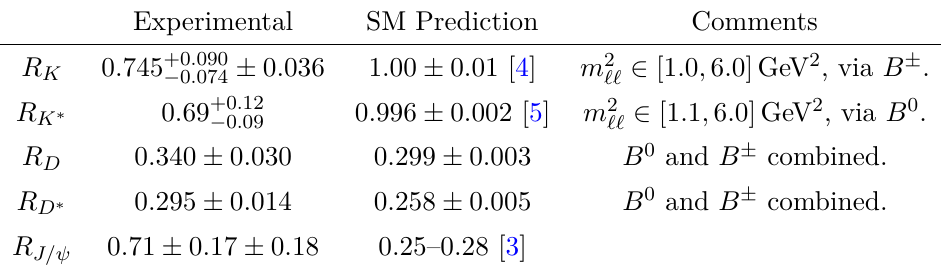
Table 1 . Summary of the B -meson anomalies. The numbers without citations are taken from